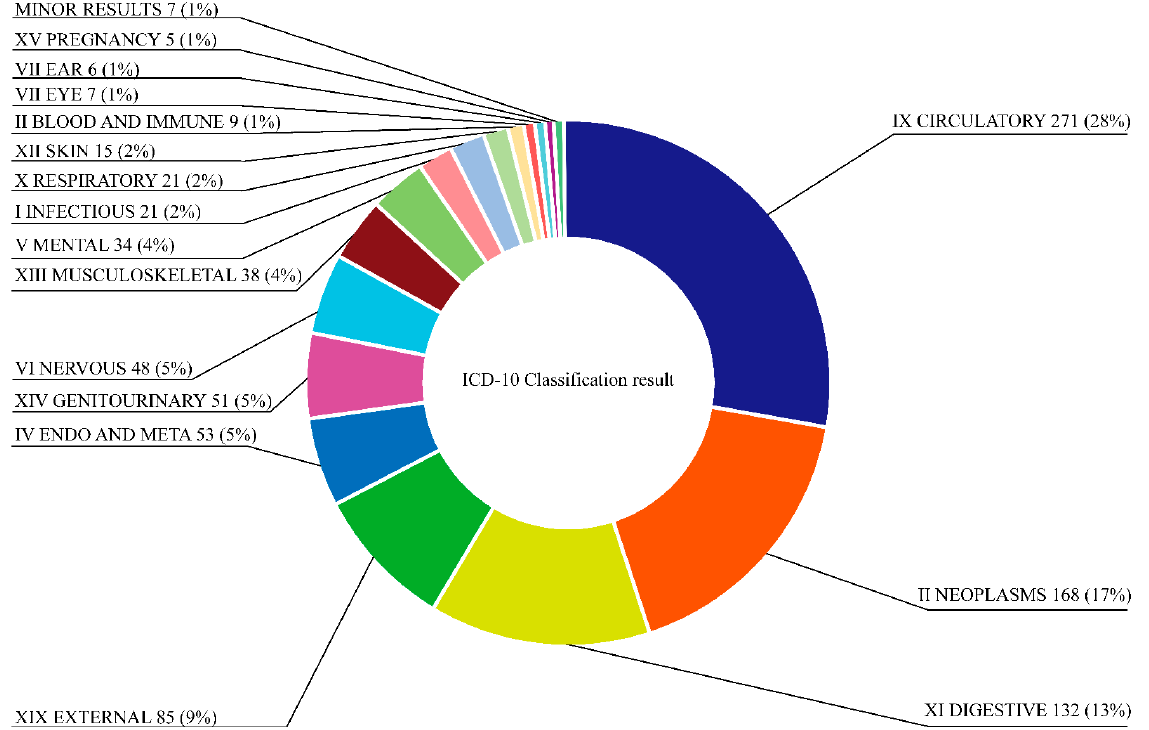
Figure 3. Overall disease classification statistics on pharmacological results of SMC. Table 2. Overall pharmacological results of SMC.